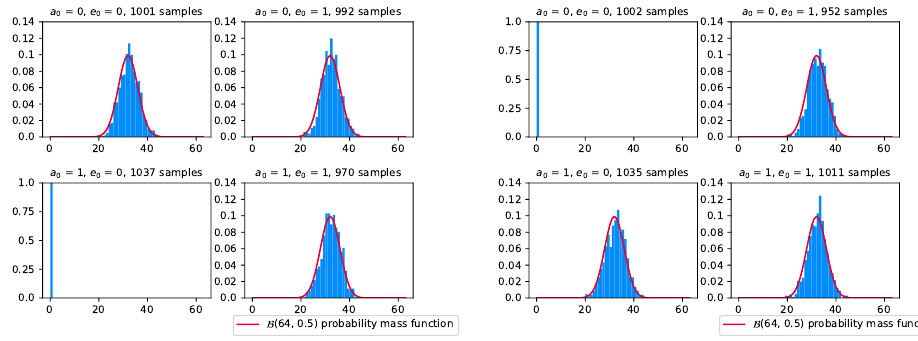
Figure 6: Distribution of the Hamming weight of cube-sum vectors for x v (left) and x w (right) depending on the values of ( a ), for 4000 capacities chosen uniformly at 0 , e 0